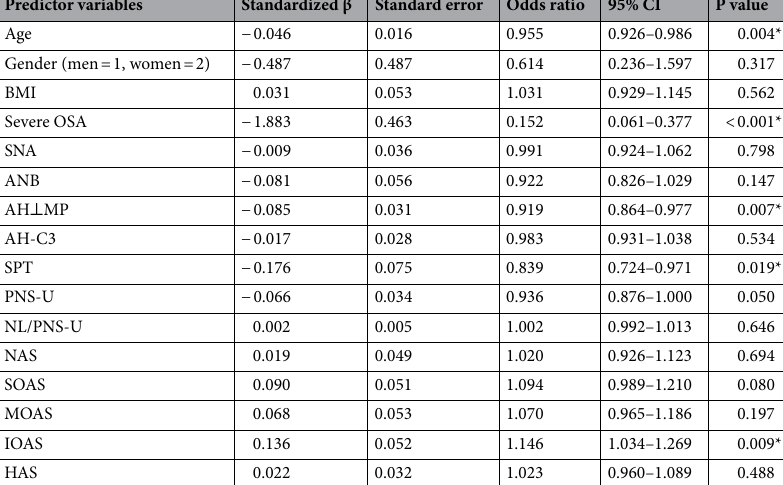
Table 7. Logistic regression analysis of the risk factors on REM dependency. REM, rapid eye movement sleep; CI, confidence interval; BMI, body mass index; severe OSA, obstructive sleep apnea showing apnea–hypopnea index ≥ 30; SNA, smaller angle which is formed by sella(S), nasion(N), and A point; ANB, smaller angle which is formed by A point, nasion(N), and B point; AH ⊥ MP, the perpendicular distance between AH and Go-Me line; AH-C3, the distance between AH and the third vertebra; SPT, maximum width of soft palate which is perpendicular to PNS-U line; PNS-U, the distance between PNS and U; NL/PNS-U, smaller angle between ANS-Pm line and PNS-U line; NAS, nasal airway space; SOAS, superior oral airway space; MOAS, middle oral airway space; IOAS, inferior oral airway space; HAS, hyoid airway space. *Significant difference: p <